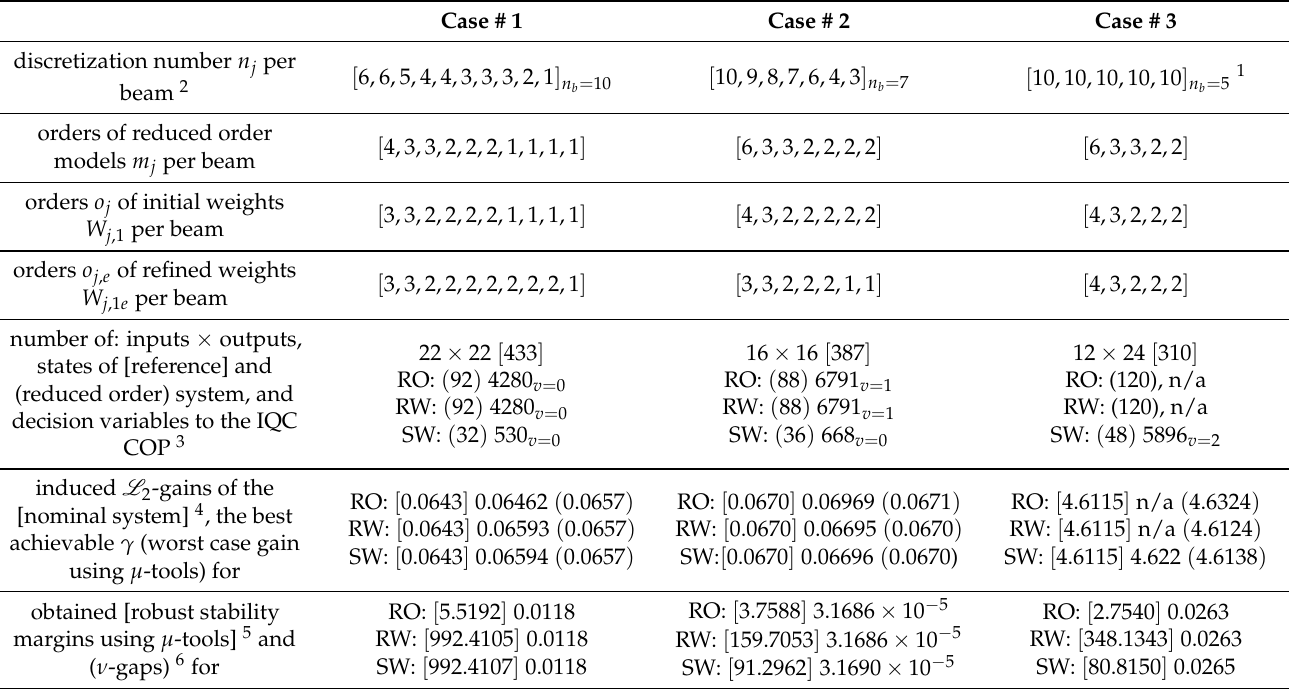
Table 2. Results after the feasible solution in the IQC robustness analysis is found. Different number of beams ( n b ) are considered. Acronyms are used for the resulting interconnected systems: RO (Reduced Order with initially calculated weights W j ,1 ), RW (reduced order with Refined Weights W j ,1 e ) and SW (reduced order with Static Weights W j ,1 s ). The McMillan degree v of basis-function needed to achieve solution is also displayed. The numerical simulations were carried out on a Linux 64bit machine with Dual Core Intel i5-3317U 2.6GHz and 8Gb RAM, in Matlab version 9.11 and IQCLab Toolbox